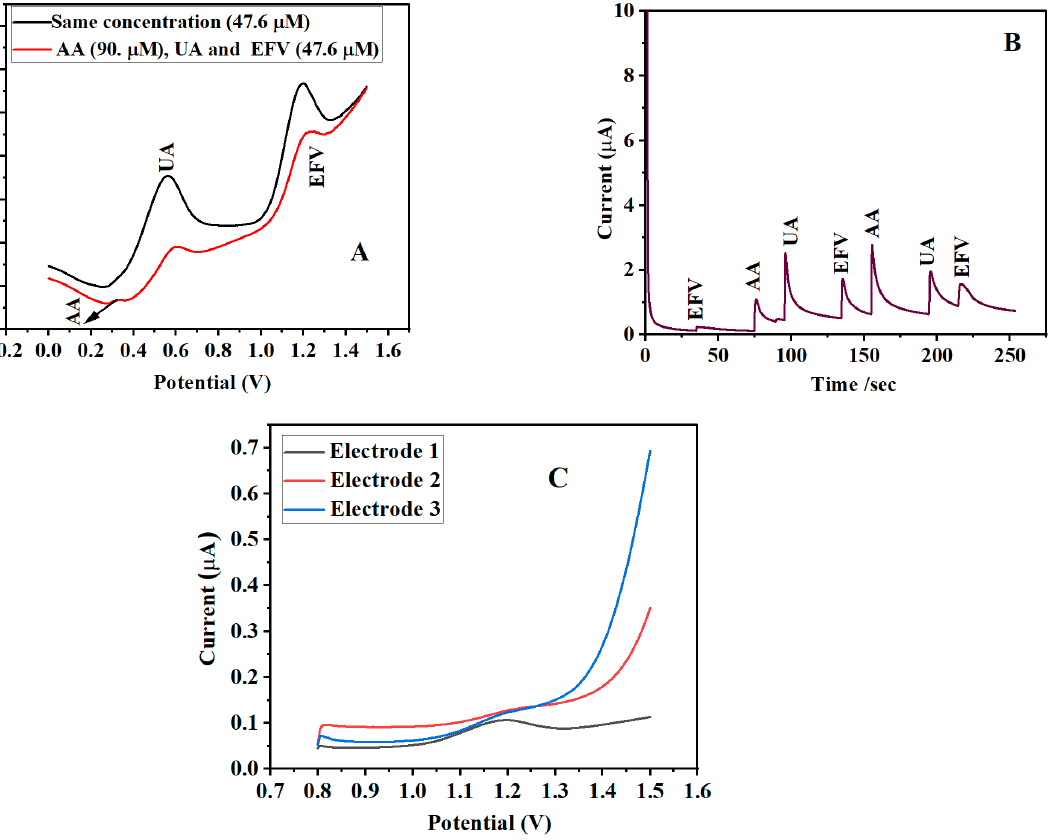
Figure 9. ( A ) The simultaneous determination of 47.6 µM of EFV, AA, and UA on GCE/TiO 2 -NPs- nafion by DPV, ( B ) Chronoamperometric curve of GCE/TiO 2 -NPs-nafion in pH 7 PBS containing EFV, AA, and UA, and ( C ) reproducibility study on three independent electrodes by DPV in 0.1 M PBS containing 47.6 µM of EFV.